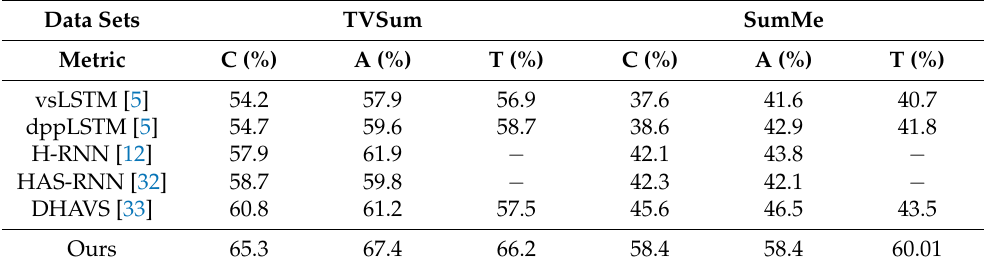
Table 4. Performance analysis of methods based on “Bi-LSTM+”.